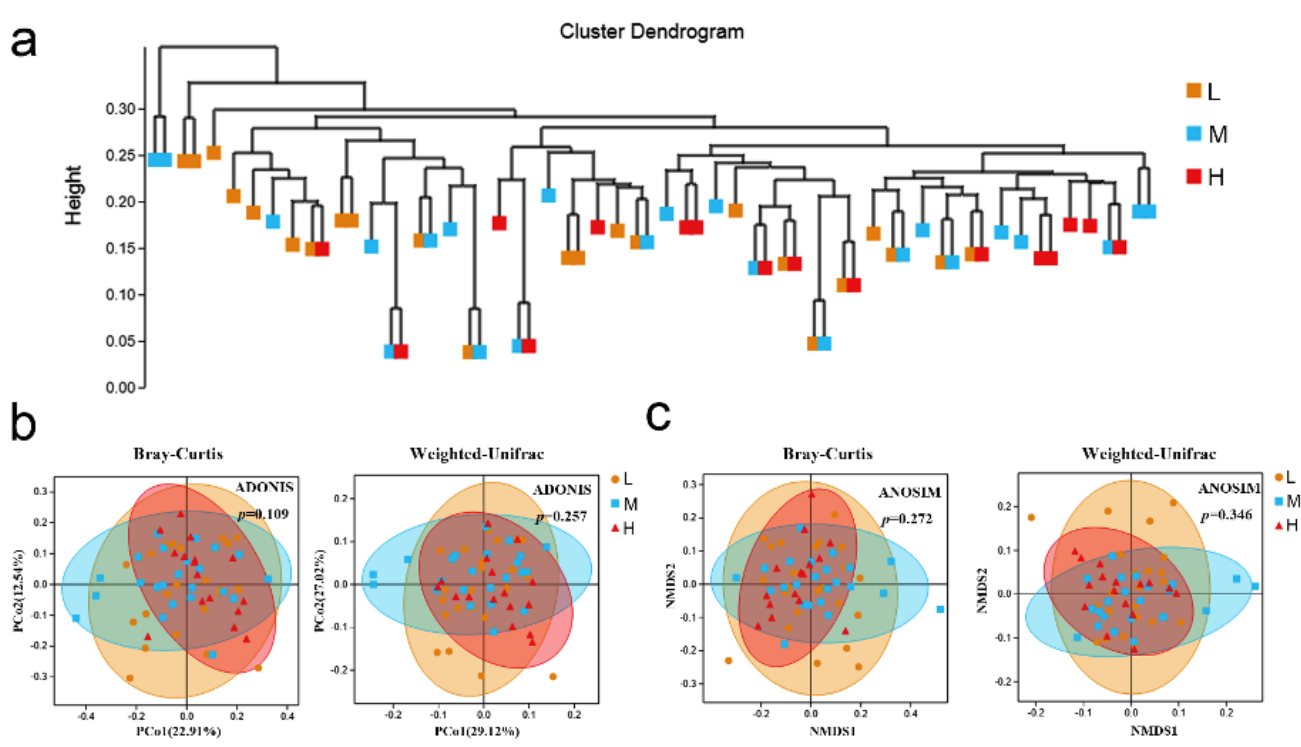
Figure 3. Beta-diversity analysis of fecal microbes among different groups. ( a ) UPGMA cluster tree was used to show the similarity among different groups. ( b ) PCoA based on the Bray–Curtis dissimilarities or weighted-UniFrac dissimilarities. ( c ) NMDS built on the Bray–Curtis dissimilarities or the weighted-UniFrac